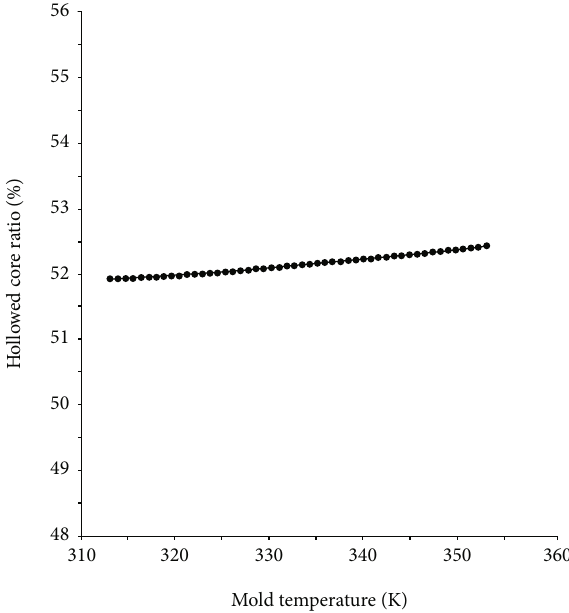
Figure 8: E ff ect of melt temperature on hollowed core ratio.